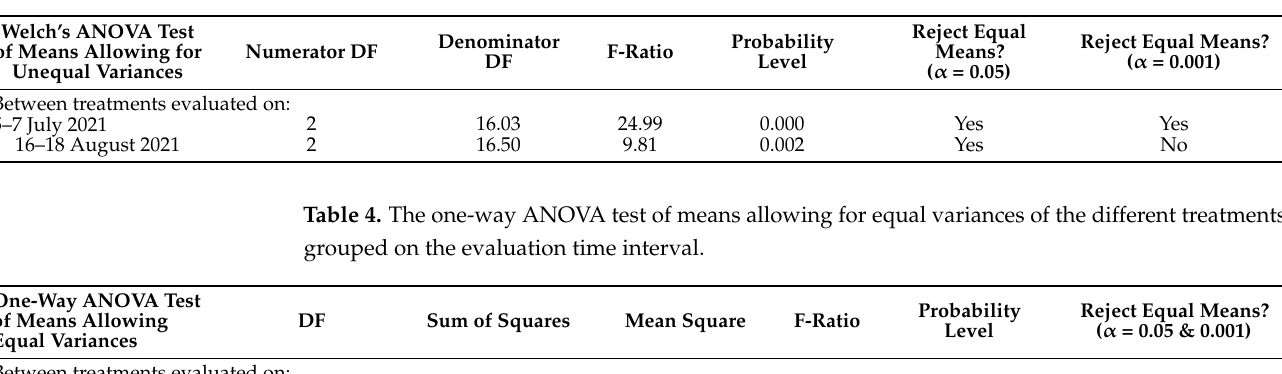
Table 3. The Welch’s ANOVA test of means, allowing for unequal variances of the different treatments grouped on the evaluation time interval.